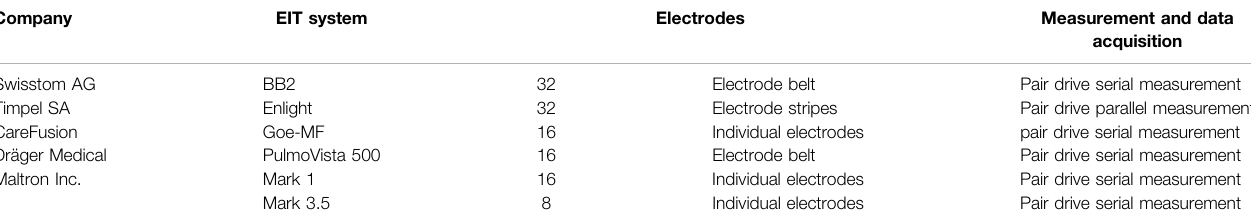
TABLE 3 | Hardware composition of EIT in some production companies [Adapted from Putensen et al. (2019)].